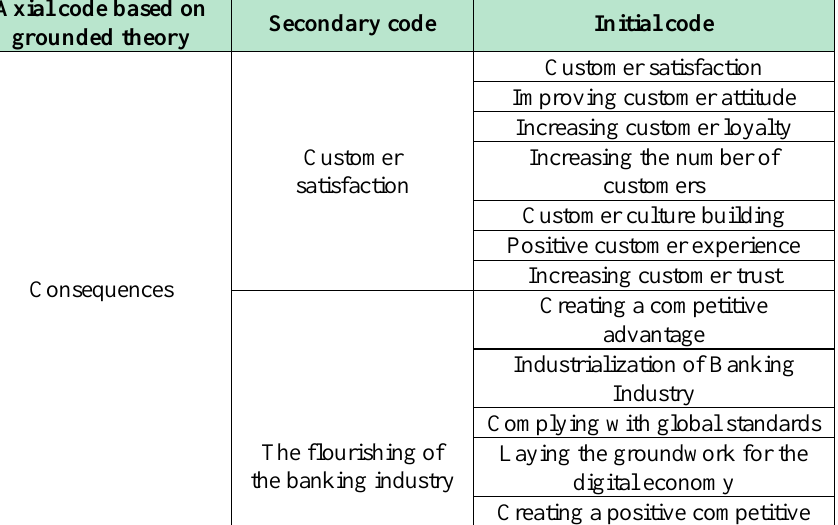
Table 3: Open coding of qualitative data (Consequences) Axial code based